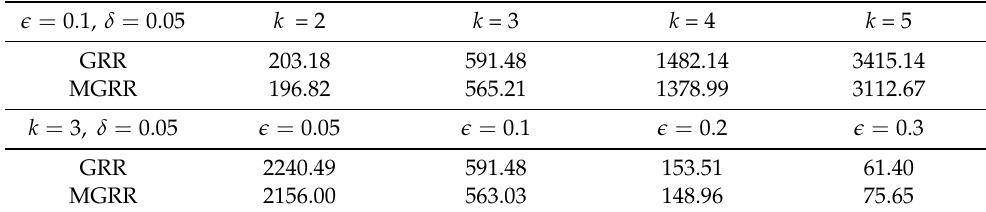
Table 2. Mean number of games needed by GRR and